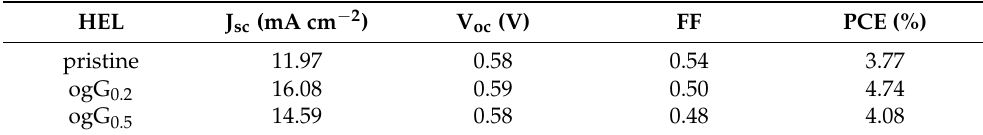
Table 1. Photovoltaic (PV) performance of organic PVs (OPVs) with various hole extraction layers (HELs) a .